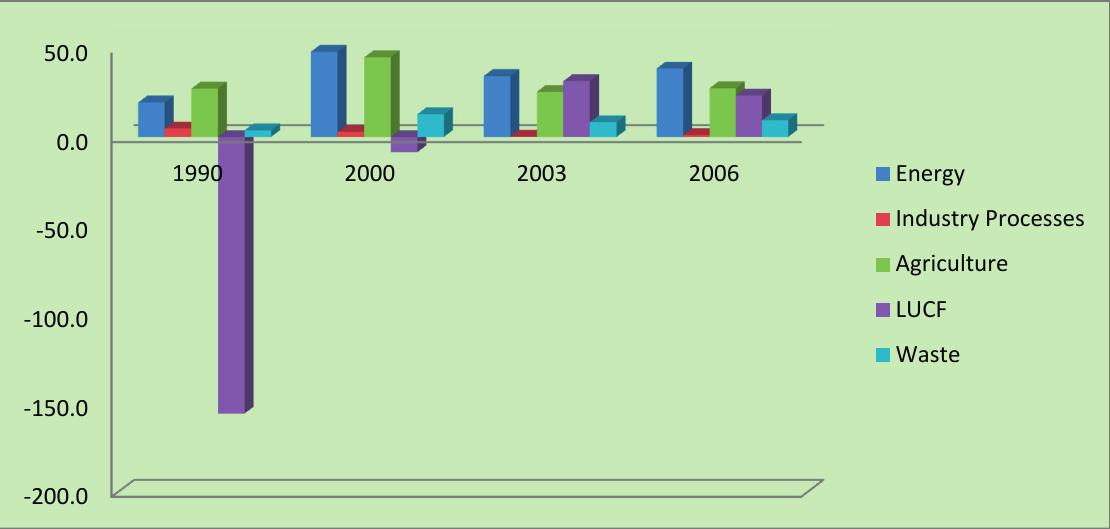
Figure 2. Sectoral Emissions of Greenhouse Gases.Source: Authors’ computation based on data from [1].